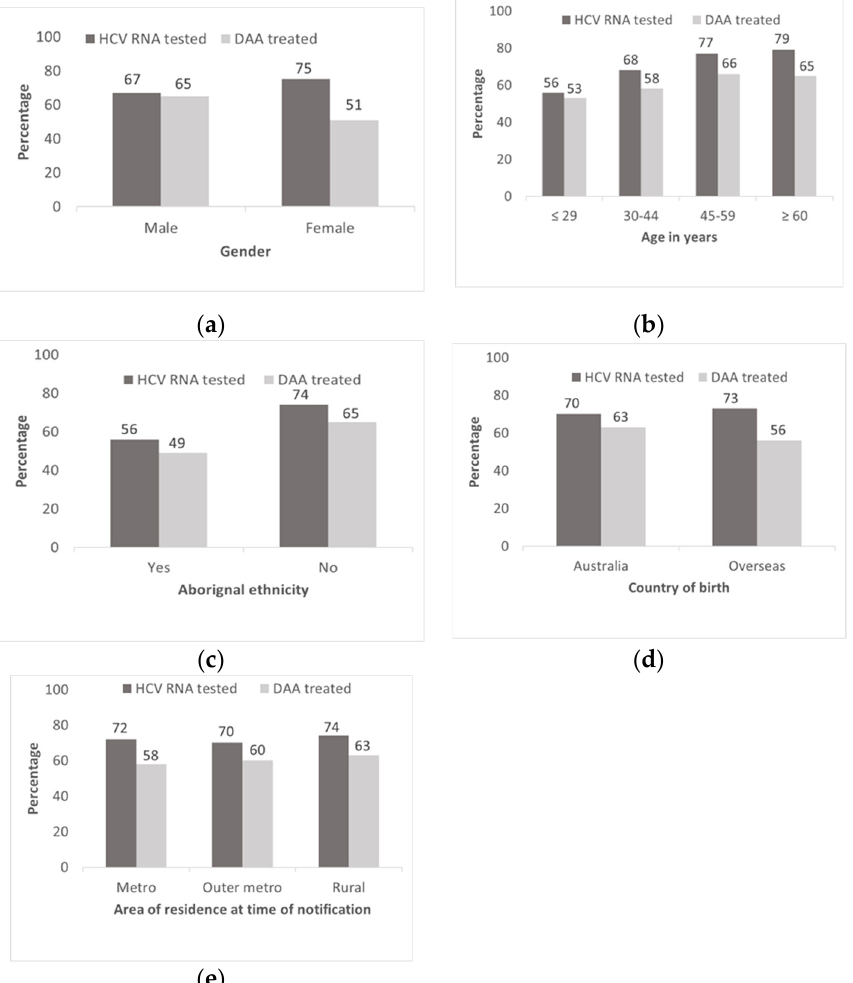
Figure 2. Proportion of HCV RNA testing and DAA treatment by key factors among people with an HCV notification in NSW 2016–2018; ( a ) gender; ( b ) age groups; ( c ) Aboriginal status; ( d ) country of birth; ( e ) area of residence.